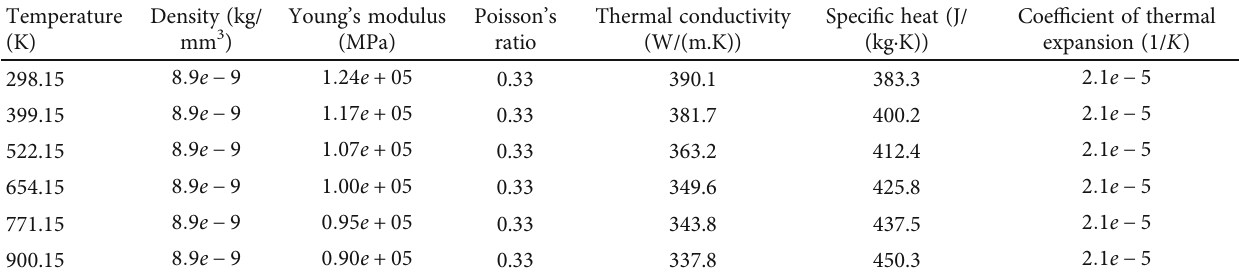
Table 3: Basic data for the bullet jacket material.